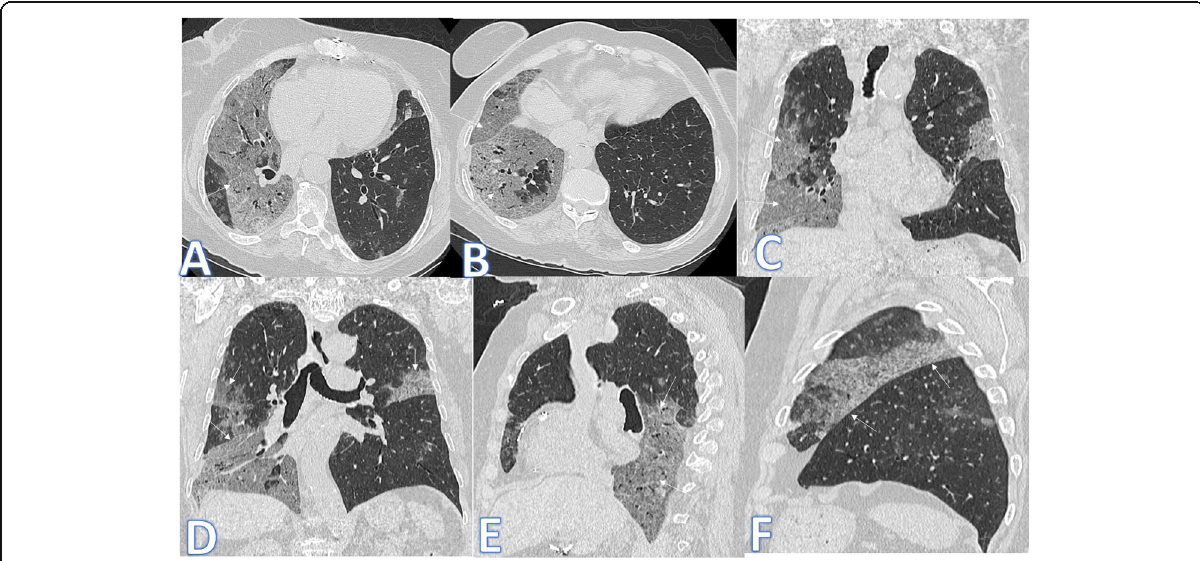
Fig. 11 A 80-year-old female patient presented with cough. CT showed bilateral asymmetrical GGO with crazy paving appearance (arrows) near totally involving the right middle and lower lobes with less involvement of the left lung. The diagnosis was